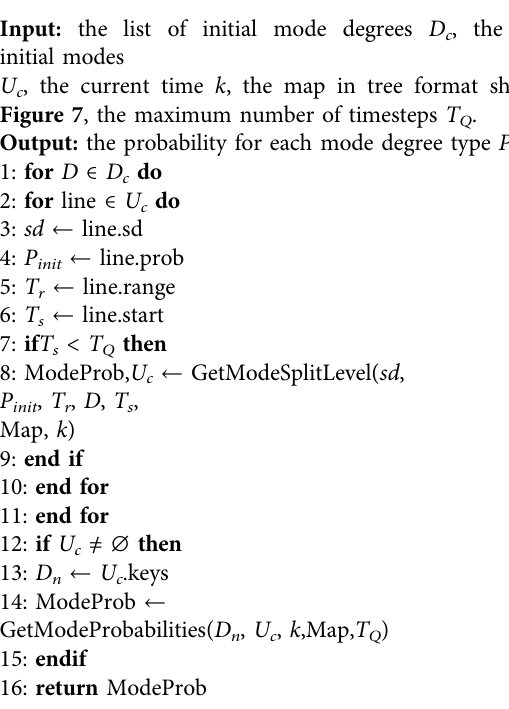
Algorithm 2 GetModeProbabilities( D